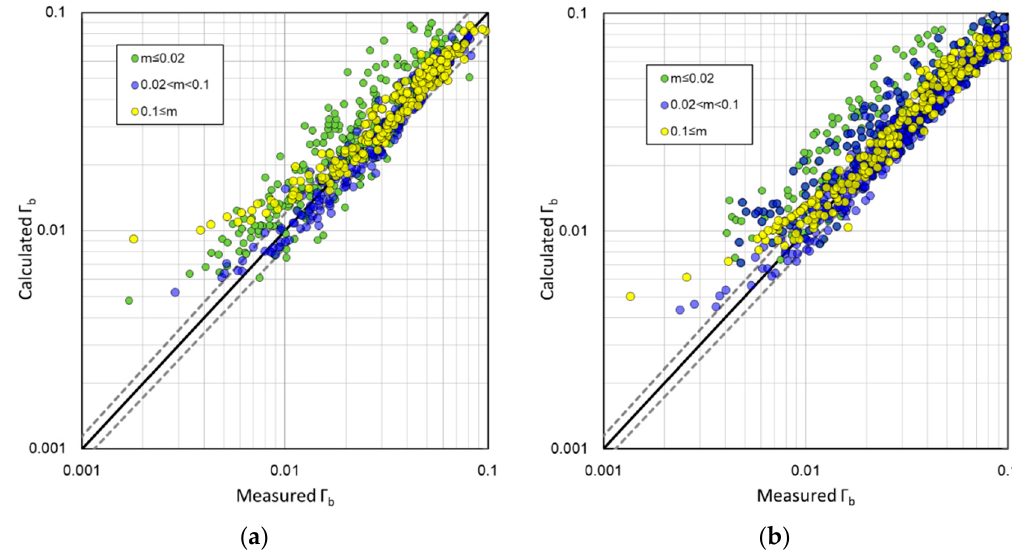
Figure 8. The predicted results by the new formula: ( a ) estimated wave breaking height; ( b ) estimated wave breaking depth.